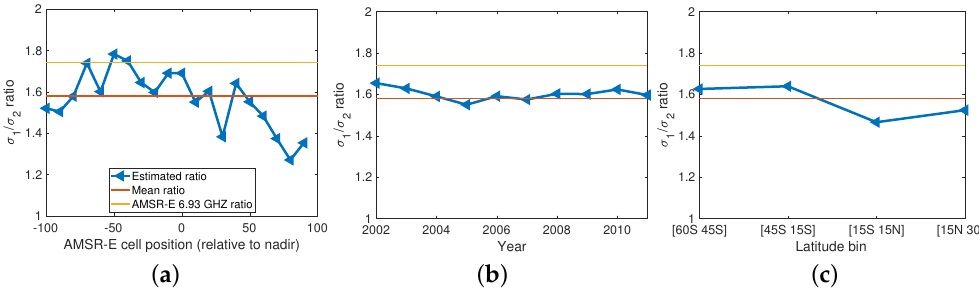
Figure 14. The σ 1 / σ 2 aspect ratio of the fitted ellipse to the 0.002 contour-line of the ( a ) across-track footprints shown in Figure 9, ( b ) year-by-year shown in Figure 12 and ( c ) those calculated as a function of latitude in Figure 11. The mean aspect ratio value corresponding to the ellipse fitted to the footprint shown in Figure 10 is plotted in red. The theoretical value corresponding to the 6.93GHz channel aspect ratio is plotted in yellow ( ≈